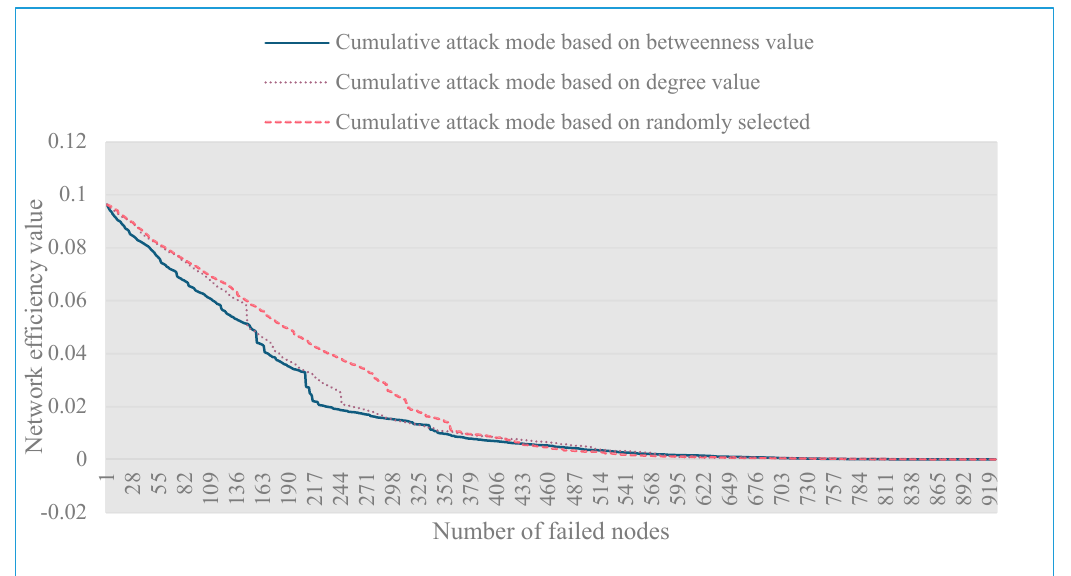
Figure 10. Analysis results of the road network efficiency from various attack modes for the study area (Source: self-drawn by the author).